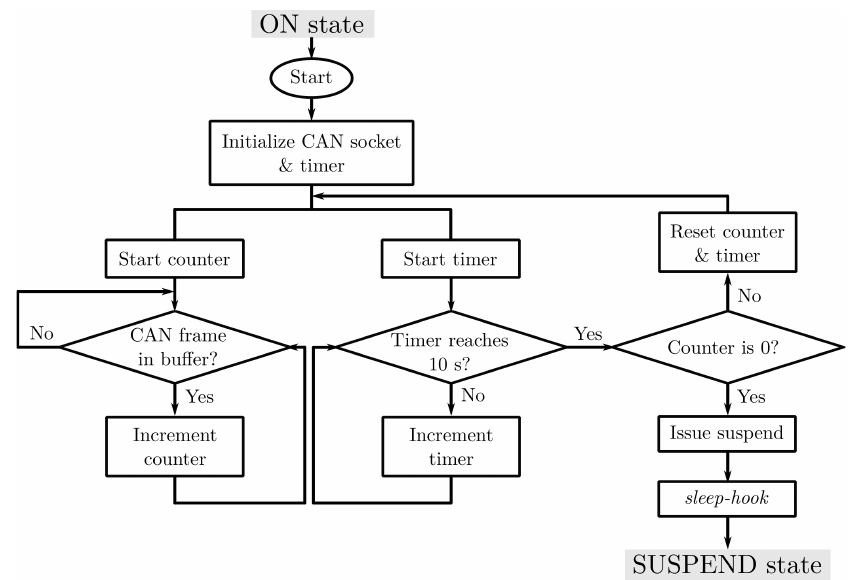
Figure 8. A custom application called can-watchdog manages system power by checking the number of CAN frames received within a resettable time period. Whenever no CAN frame is received within the timer period, can-watchdog issues a command that suspends the board and triggers sleep-hook to toggle the GPIO pin to low for cutting the power to the PoE switch and the cameras.